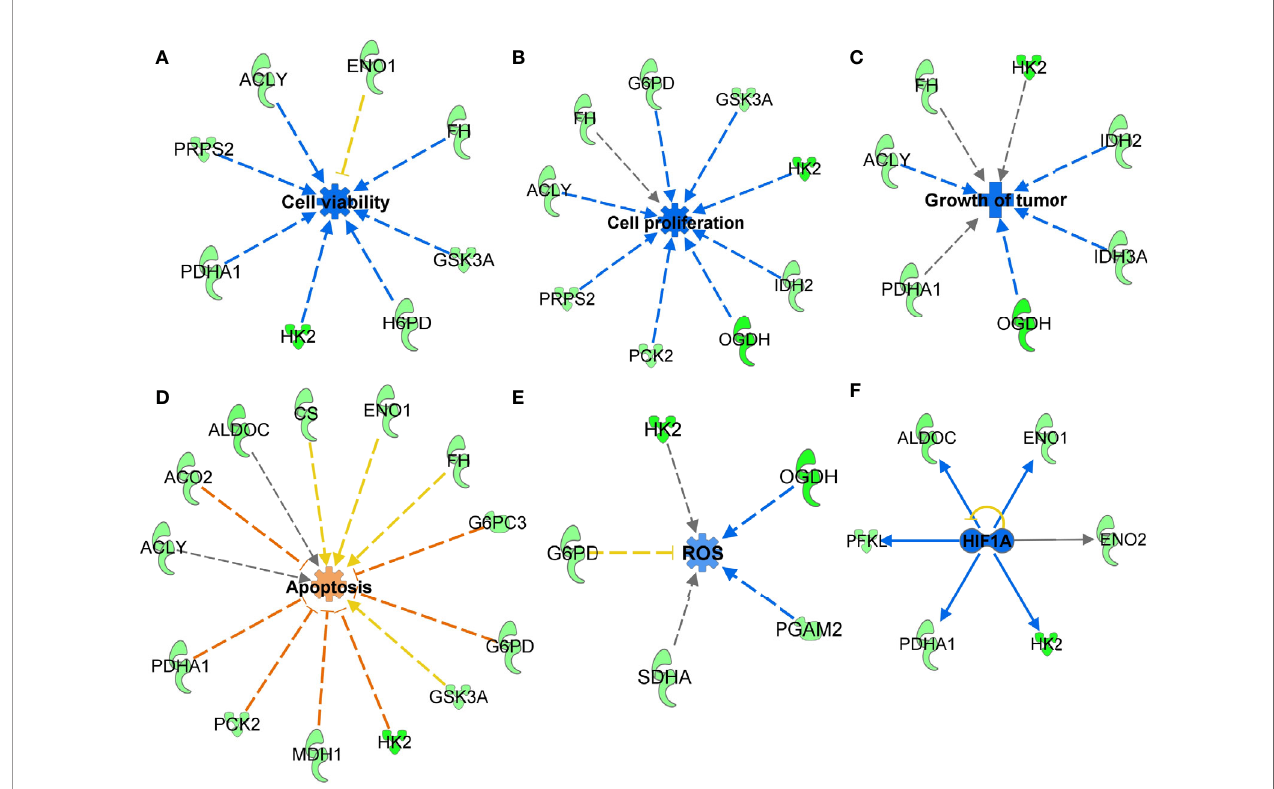
FIGURE 4 | Functions annotation of glucose metabolism genes identi fi ed in response to SIRT3 knockdown (shSIRT3- SK-MEL-2). The cumulative effect of SIRT3 modulated genes were analyzed using IPA and effects were predicted for (A) cell viability, (B) cell proliferation, (C) tumor growth, (D) apoptosis and (E) ROS. Genes from the array are in green (downregulated), while predicted functions and interaction lines are in blue (inhibition) or orange (activation). Yellow lines indicate inconsistent fi ndings, and gray dotted lines show unpredicted effects. (F) Using IPA, upstream regulator analysis predicted inhibition of HIF1 a . Though other upstream regulators are presented in Figure 6, HIF1 a inhibition is presented here to discuss SIRT3-HIF1 a -ROS connections in cancer